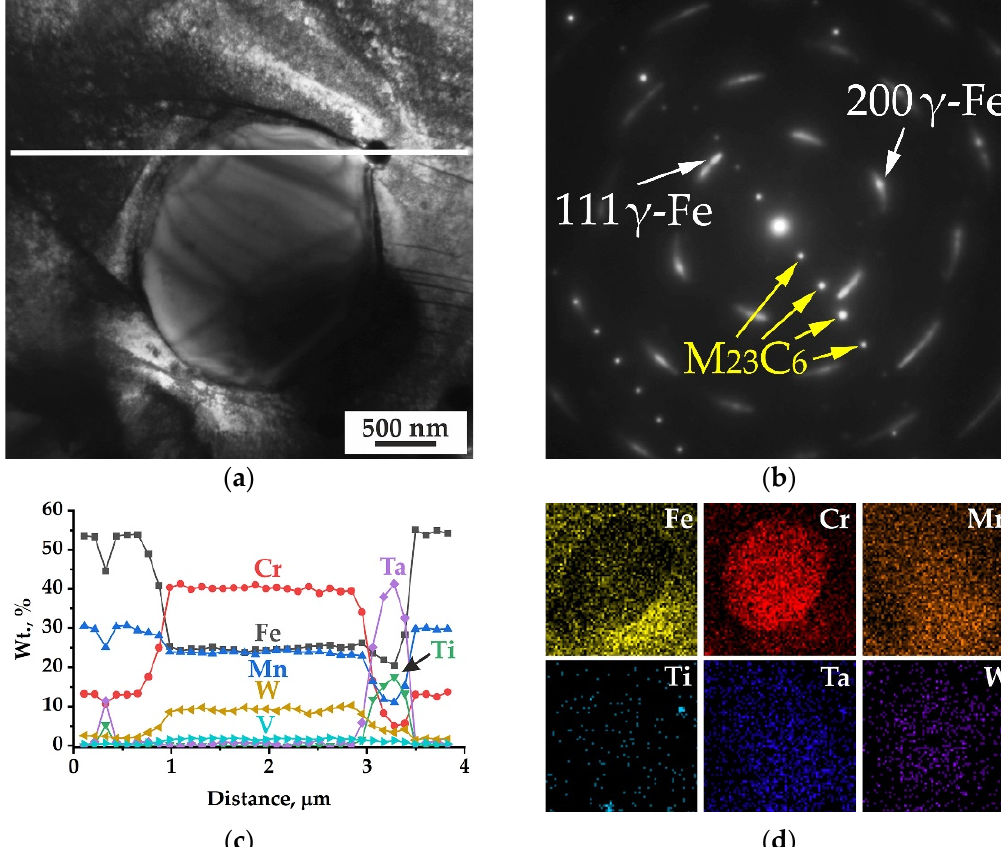
Figure 8. TEM images of coarse particle after CR. BF image ( a ), corresponding SAED pattern ( b ), reflections of matrix and particle are denoted by white and yellow arrows, respectively, EDX analysis along the line ( c ), elemental map from particle ( d ).